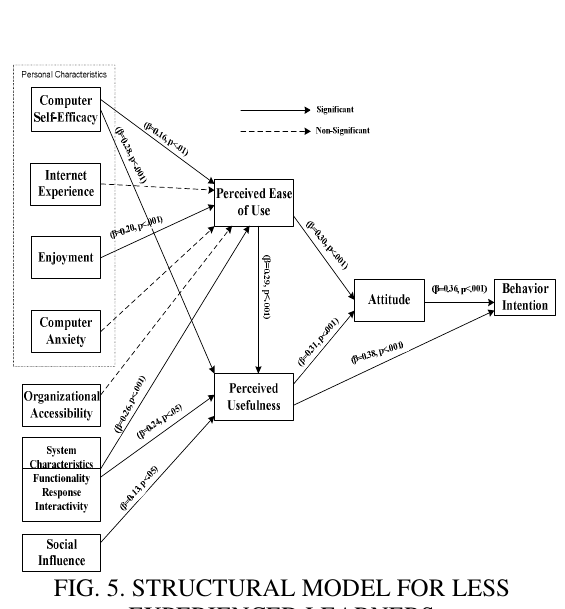
FIG. 3. STRUCTURAL MODEL FOR FEMALE LEARNERS